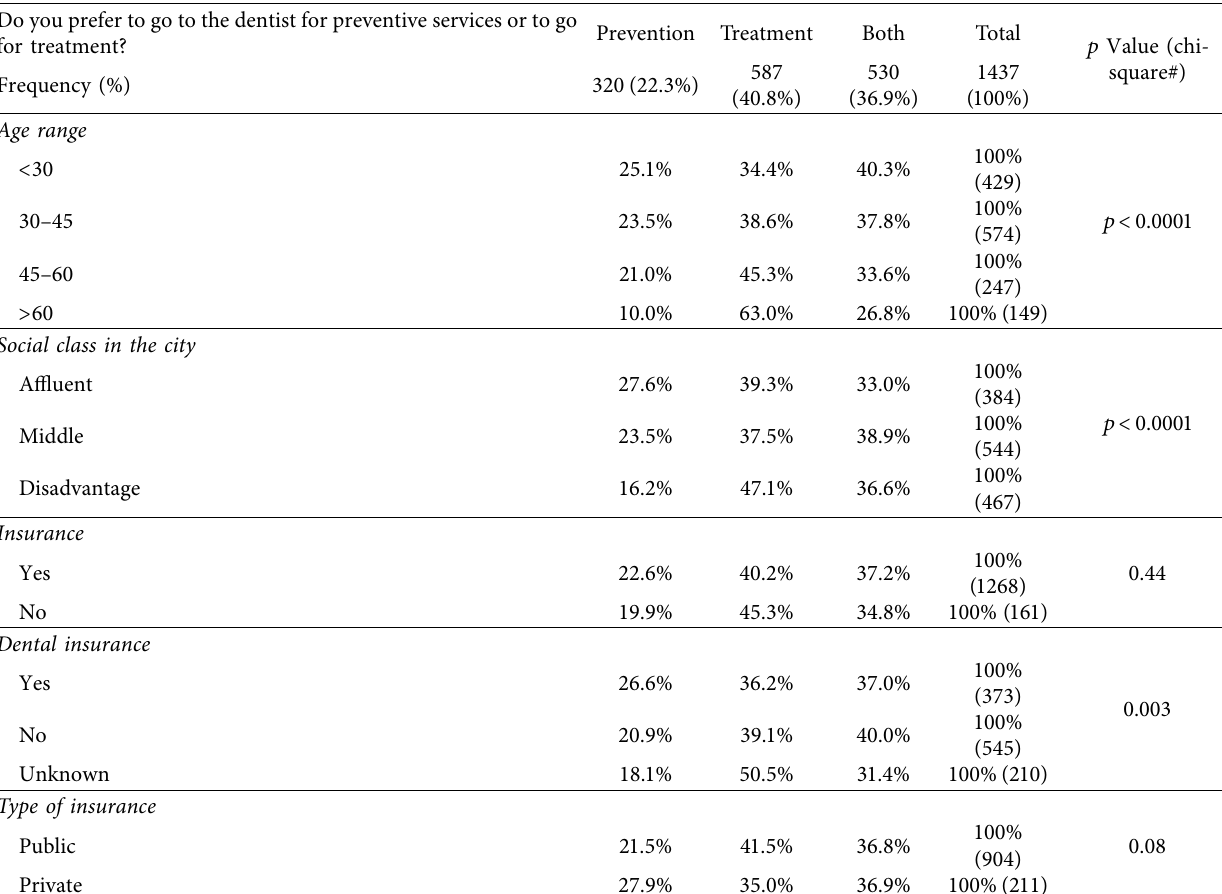
Table 4: Treatment/prevention services preference across demographic and socioeconomic respondents’ characteristics. Do you prefer to go to the dentist for preventive services or to go for